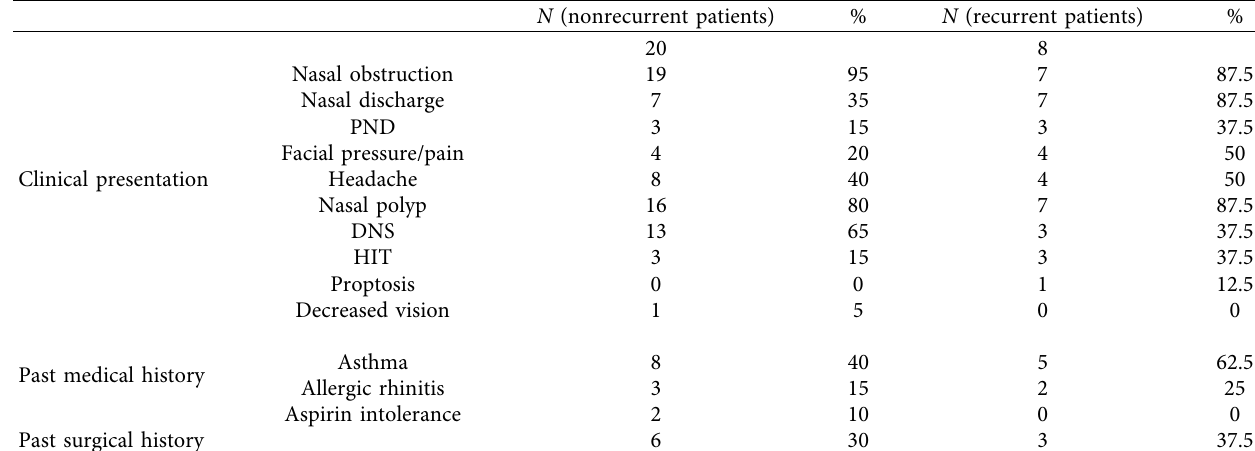
Table 2: Comparison between patients with recurrence and patients without recurrence.